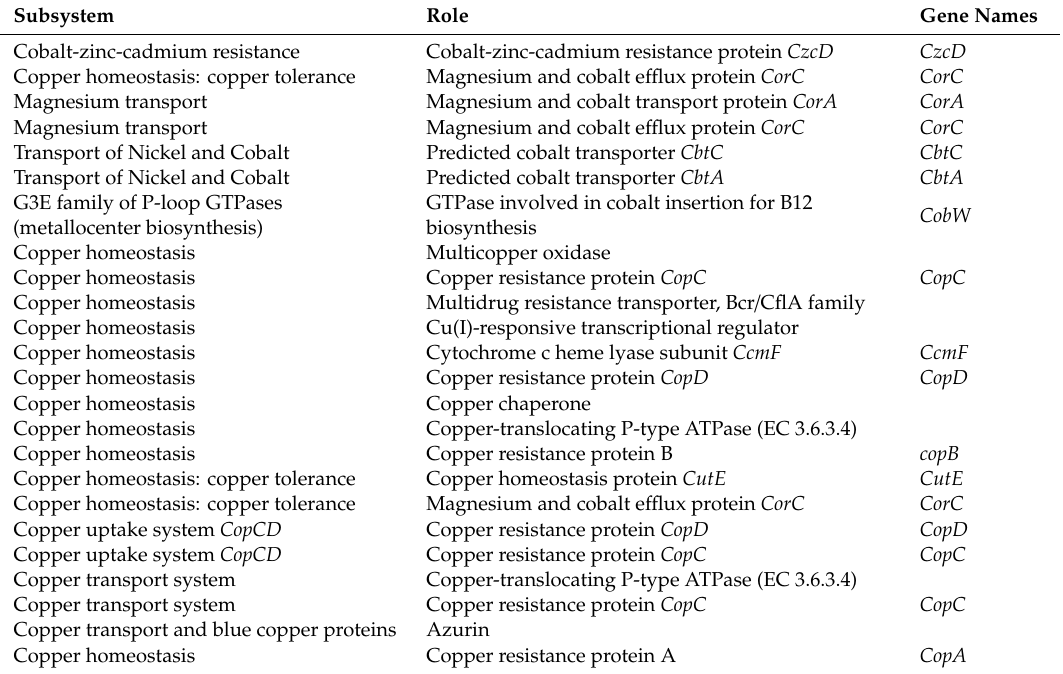
Table 3. Genes potentially involved in heavy metal resistance in the CS51